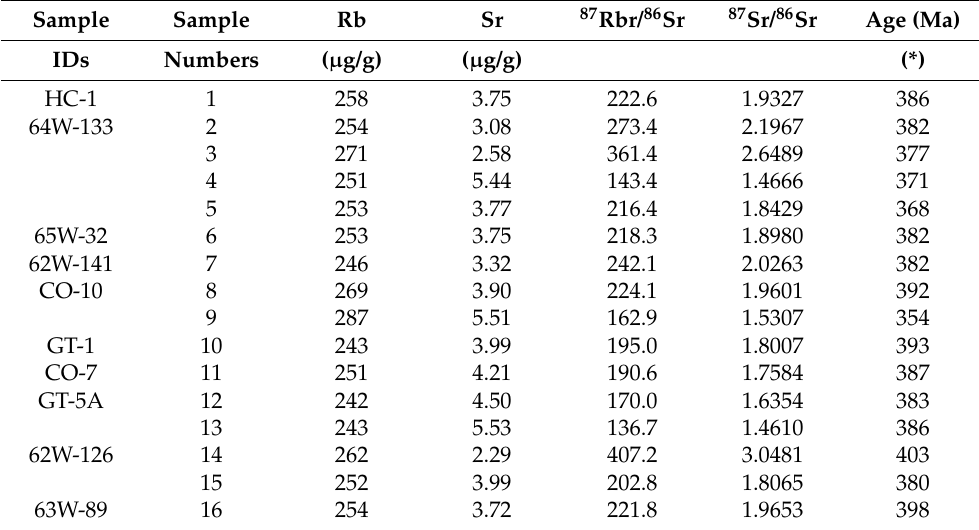
Table 5. The previously published Rb-Sr data of the glauconite-rich pellets studied here (data from Posey et al., 1983).